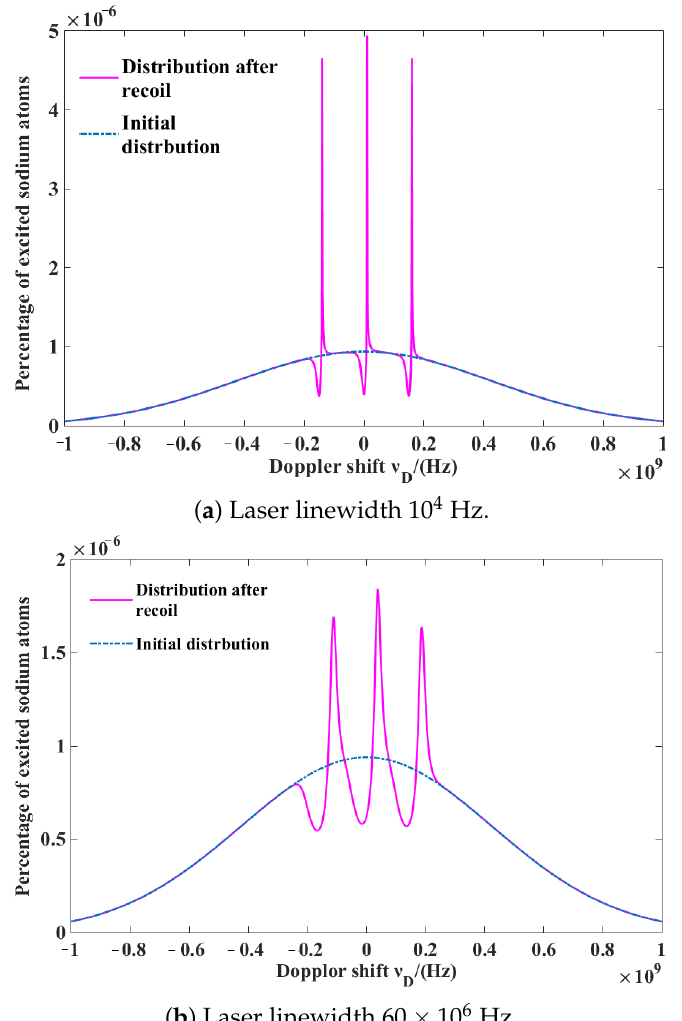
Figure 14. Normalized distributions of sodium atoms at I = 150 W/m 2 .